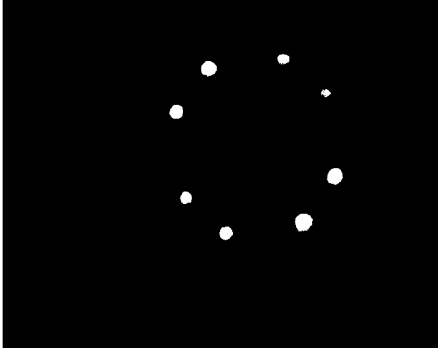
Figure 6. Extraction result of guidance features.